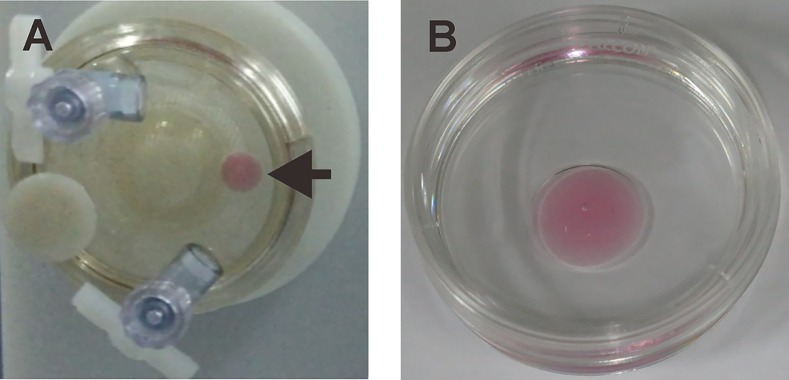
Setup of simulated microgravity and normal 1 g culture conditions.(A) s-μg was created by the rotating wall vessel at a specific speed when a droplet of medium containing ovarian tissue or follicles was in a state of constant free-fall within the moving oil. (B) A droplet of medium containing ovarian tissue or follicles was placed on the surface of a petri dish covered with mineral oil to serve 1 g condition as a control. The arrow indicates a droplet of medium.